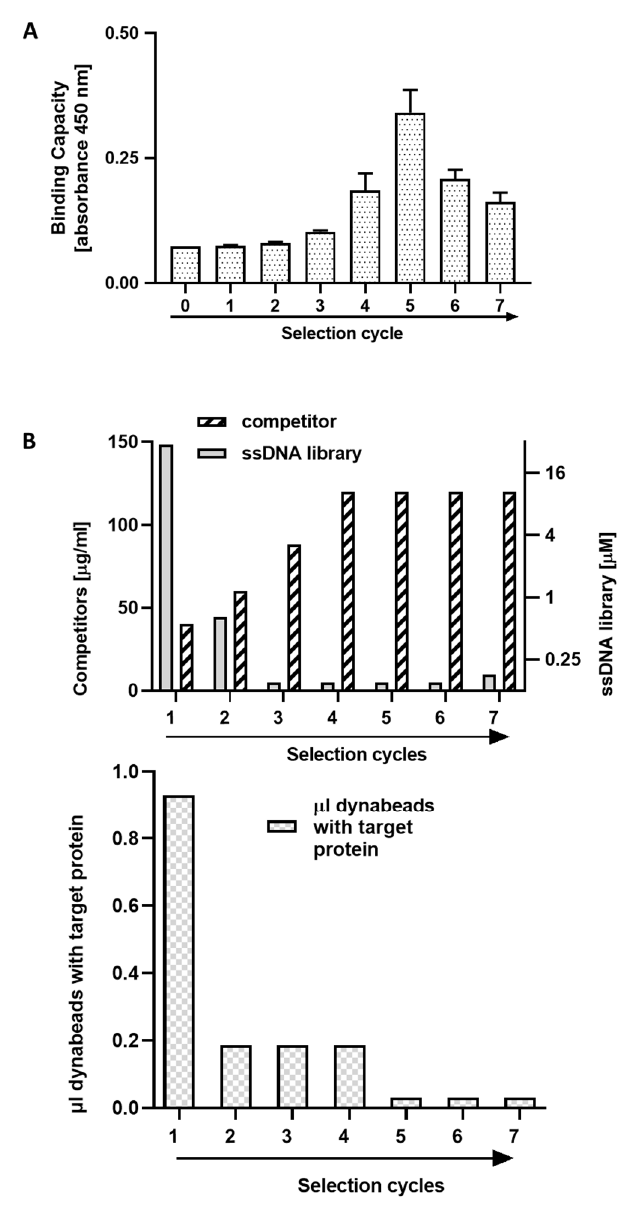
Figure 1. Selection of PD-L1 targeting aptamers. ( A ) Enrichment of ssDNA pool with aptamers recognizing the extracellular domain of PD-L1 after indicated selection cycles, determined using ELISA (binding of biotinylated ssDNA pool to immobilized target protein). ( B ) Gradual increase in selection pressure at subsequent selection cycles was obtained by increasing the concentration of competitor (ytRNA) while simultaneously decreasing the concentration of ssDNA library and target protein.